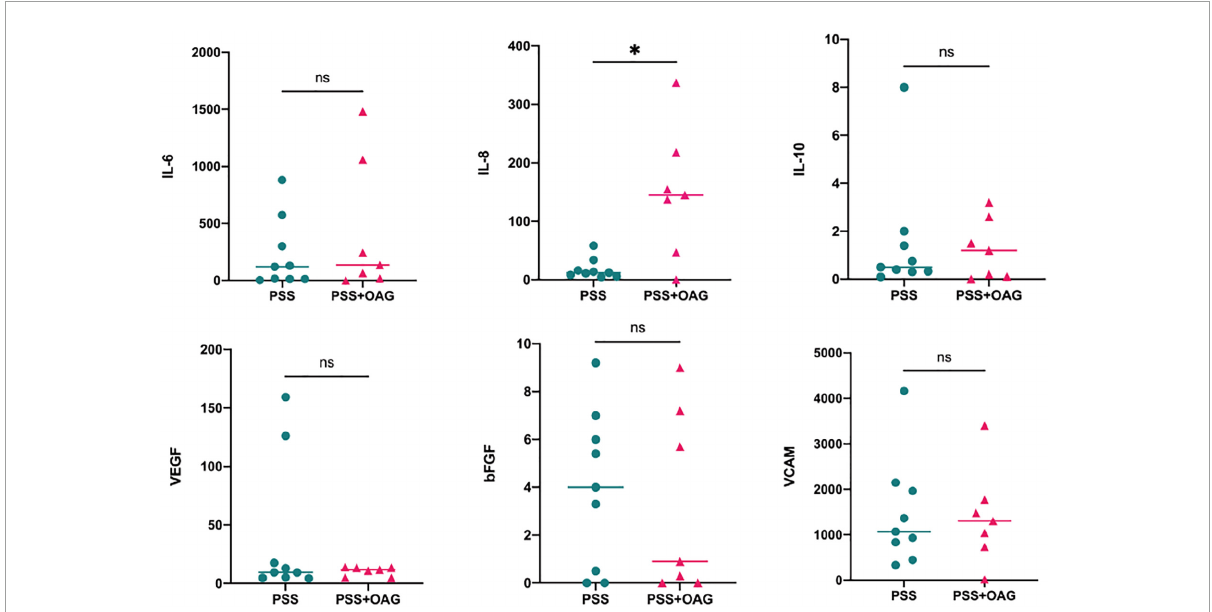
FIGURE1 Distribution of cytokine concentrations for PSS and PSS + OAG. The PSS + OAG group had significantly higher cytokine IL-8 concentration levels (145.10 [0.00-337.20]pg/ml) than the PSS group (12.20 [4.70-58.50]pg/ml). The concentration levels of IL-6, IL-10, VEGF, bFGF, and VCAM did not differ significantly between the groups. ∗ p<0.05. bFGF, basic fibroblast growth factor; IL, interleukin; OAG, open angle glaucoma; PSS, Posner-Schlossman syndrome; VCAM, vascular cell adhesion molecule; VEGF, vascular endothelial growth factor.